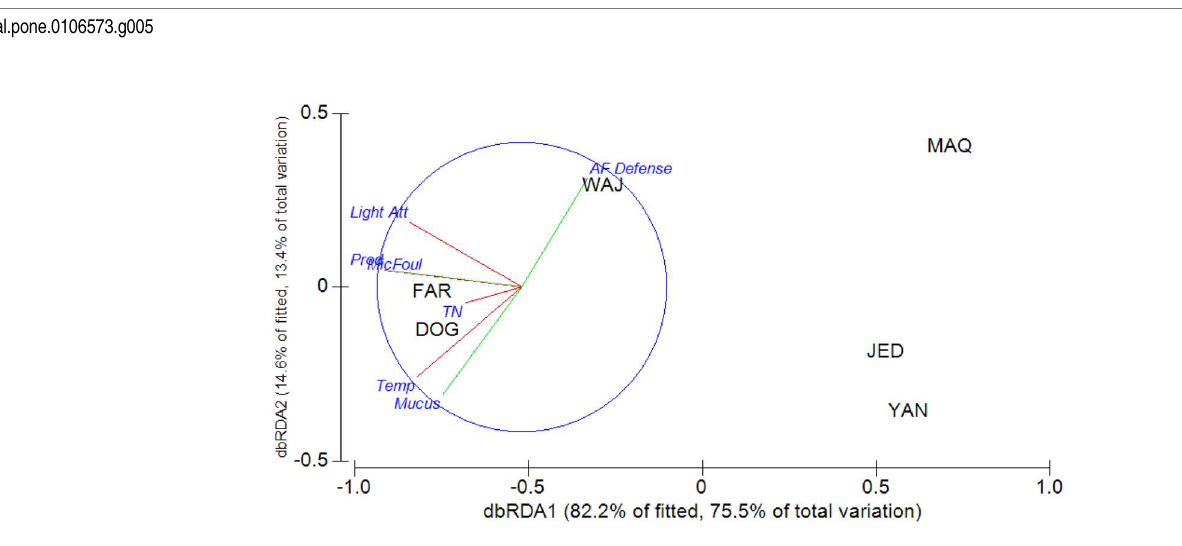
Fig. 6. Distance-based redundancy analysis triplot. The site symbols represent the P. verrucosa populations distributed according to the similarities regarding the 3 ‘‘response’’ variables (productivity [‘‘Prod’’], mucus production [‘‘Mucus’’], antifouling defense strength [‘‘AF Defense’’]). Axis 1 relates negatively to light attenuation [‘‘Light Att’’], microbial fouling pressure [‘‘MicFoul’’] and temperature [‘‘Temp’’]. Axis 2 relates positively to light attenuation and microfouling, negatively to temperature. TN explains relatively little of the variance. Productivity relates positively to light and microfouling, mucus positively to temperature and defenses negatively to temperature. Stats results in S1–S5 Tables. (The 7 th pristine site, Mastura, is not shown because we have no mucus release data from that